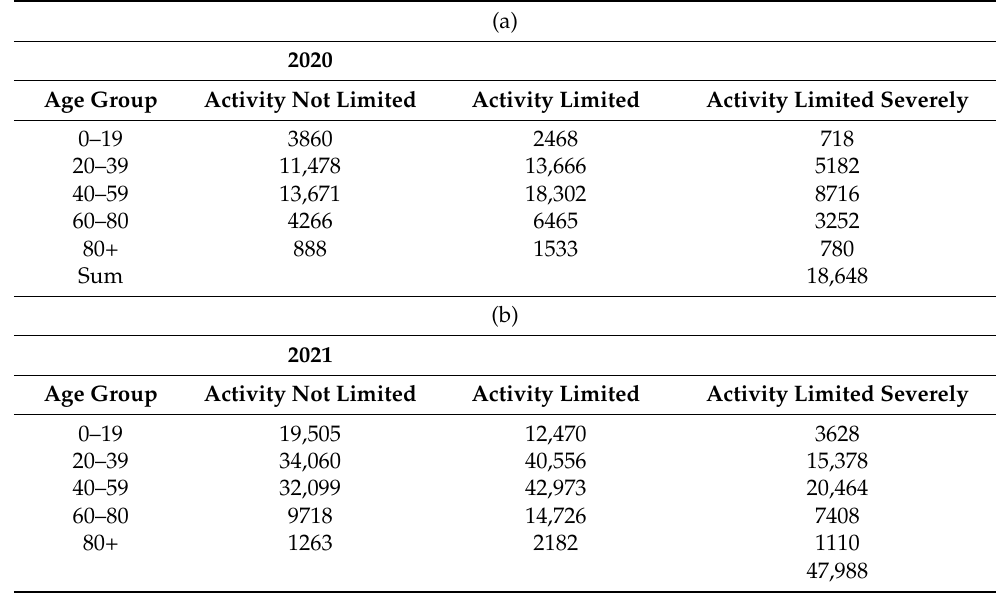
Table A5. (a) Estimated long-Covid population numbers per age group. (b) Estimated Long-Covid population numbers per age group.